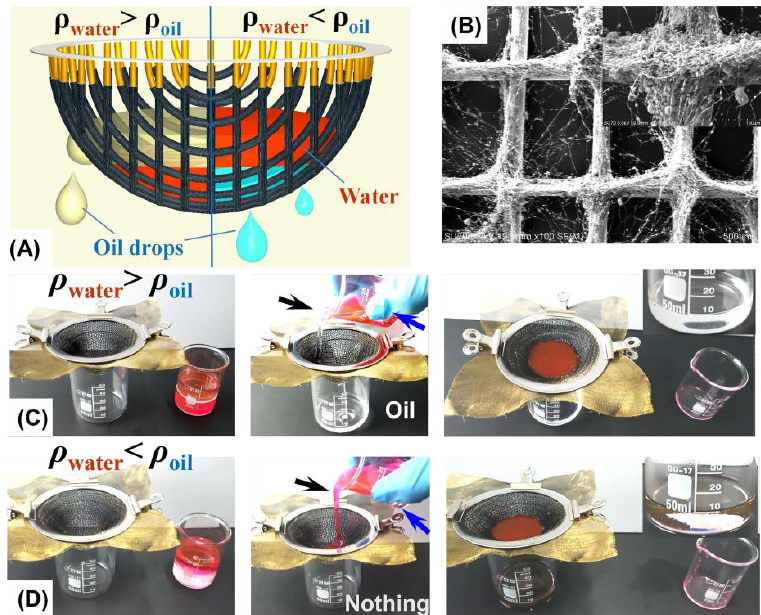
Figure 5. ( A ) Schematics of a superhydrophobic and superoleophilic “Taylor cone”-like 3D mesh container for both light and heavy oil/water separation; ( B ) SEM image of the coated copper mesh with electrosprayed PVDF/CS composites (enlarged in inset); snapshots of the use of the mesh container to separate light oil/water mixtures ( C ) and heavy oil/water mixtures ( D ), where hexadecane and chloroform are used as light and heavy oils, respectively. The water was dyed red.